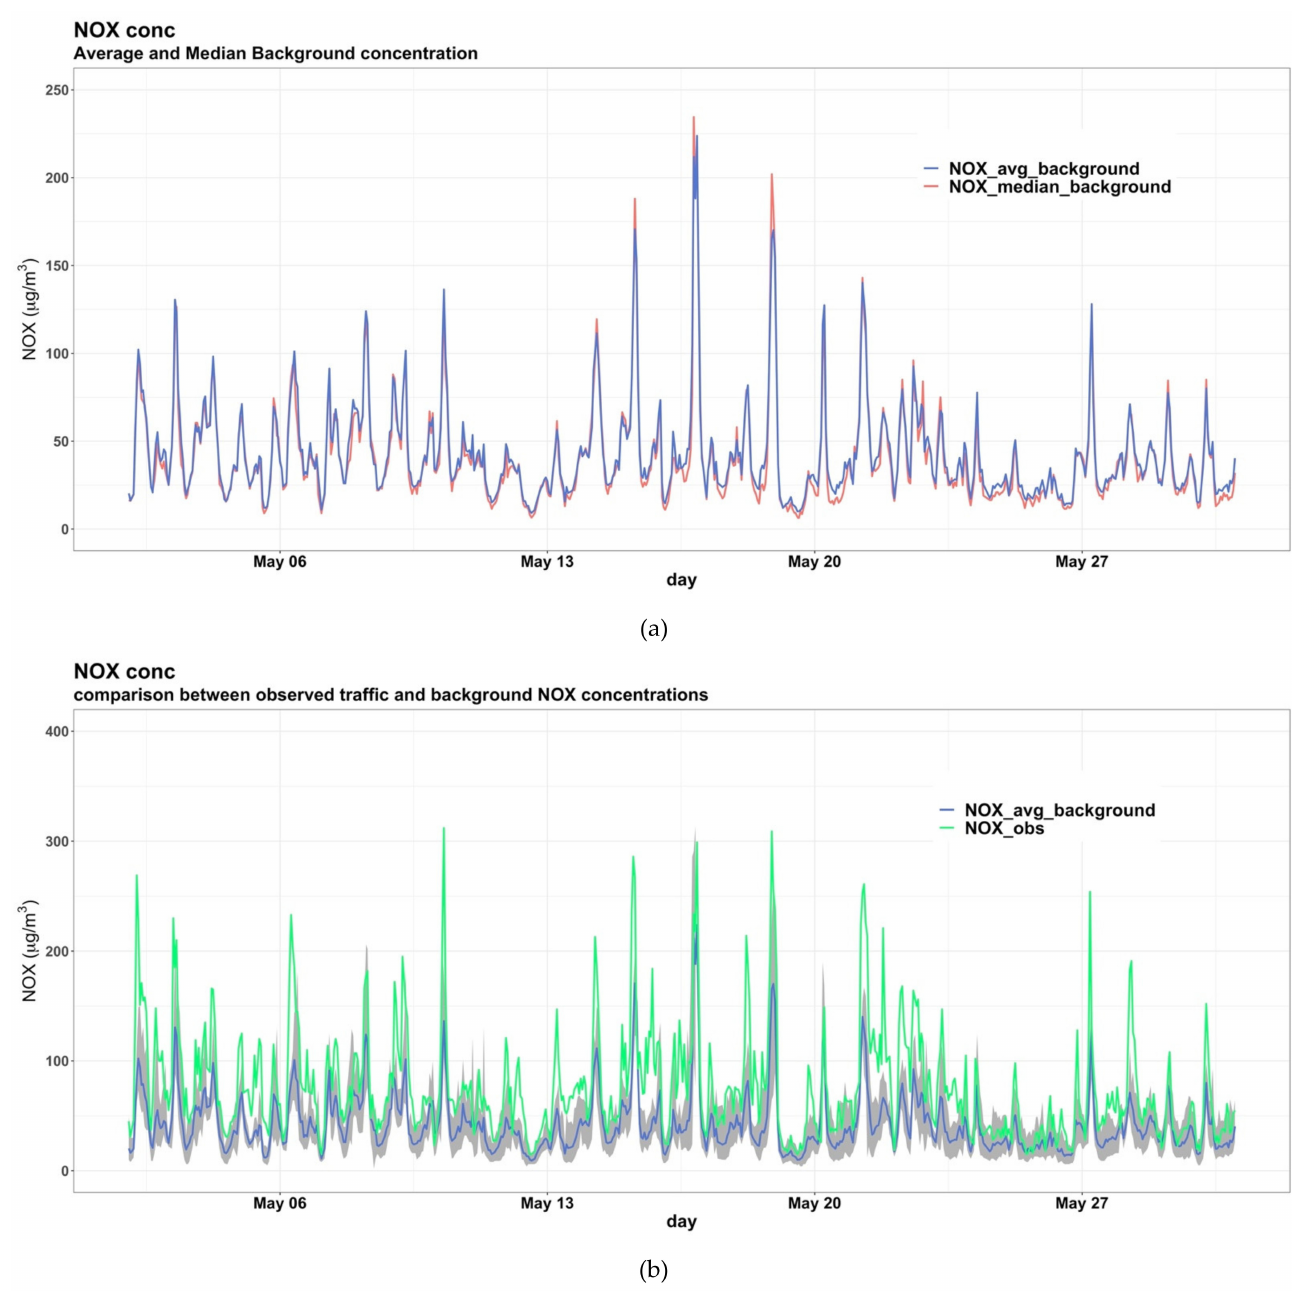
Figure 6. Time series of the main statistics parameters calculated for the NO X concentrations of the urban background AQ stations surrounding the simulation domain. ( a ) Average background NO X concentration compared to median concentration. ( b ) Average background in blue with the shaded grey area between the minimum and maximum values and the traffic station observed concentration in